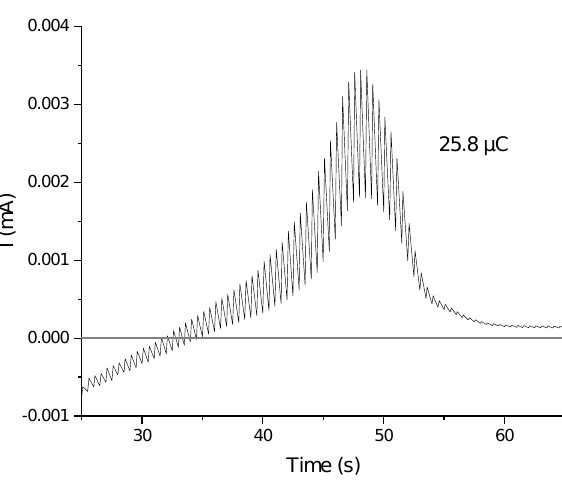
Figure 9. Dependence of current on time during the DPASV measurement for the sample of SIL- prop-COOAg 9 (containing 10% of functional groups) with depicted peak area corresponding to the charge transferred during the electrode